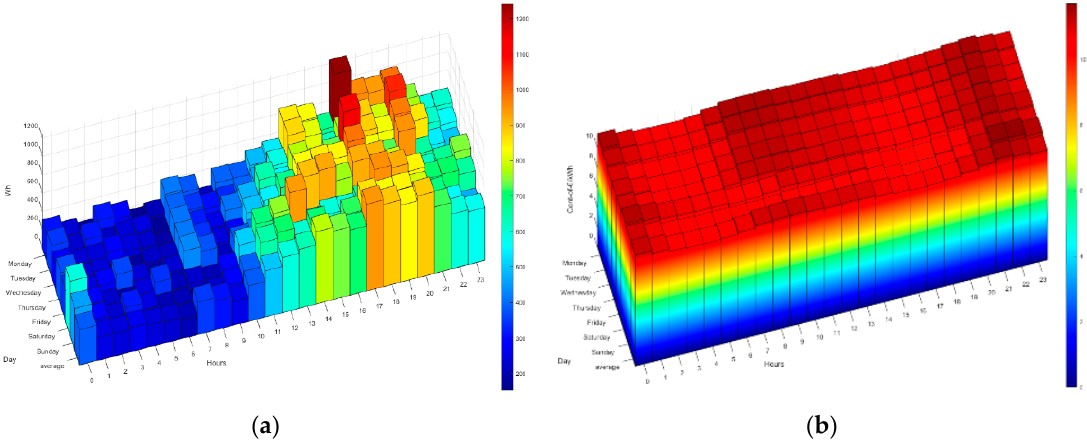
Figure 15. P1. ( a ) Average consumption (Wh) and ( b ) average prices (€ cents per kWh) during the first period (tariff 2.0A).